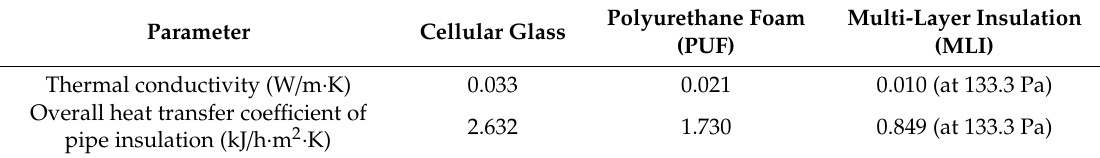
Table 6. Properties of insulation materials.